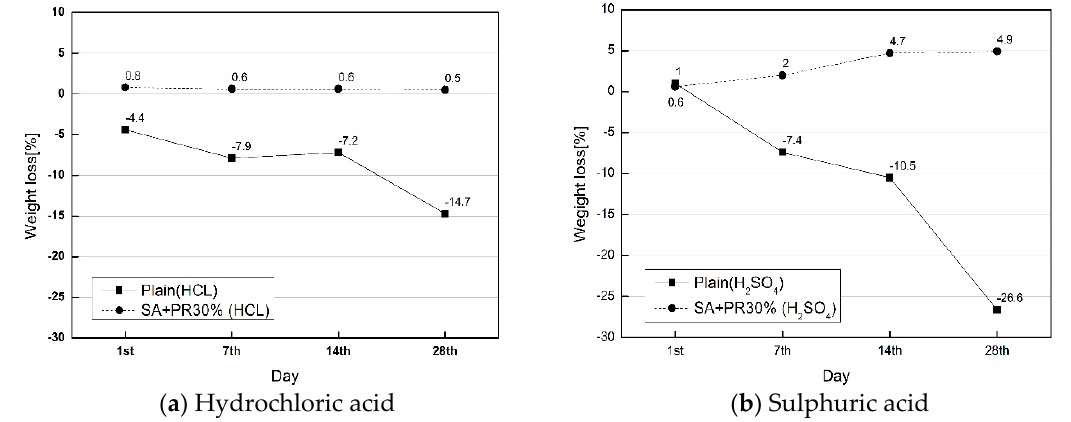
Figure 6. Weight loss of specimens.